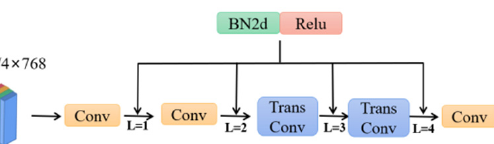
Figure 4. Schematic diagram of the inserting position of the normalization activation layer: red is activation function; red is activation function; green is batch normalization; yellow is convolution; blue is transpose convolution.